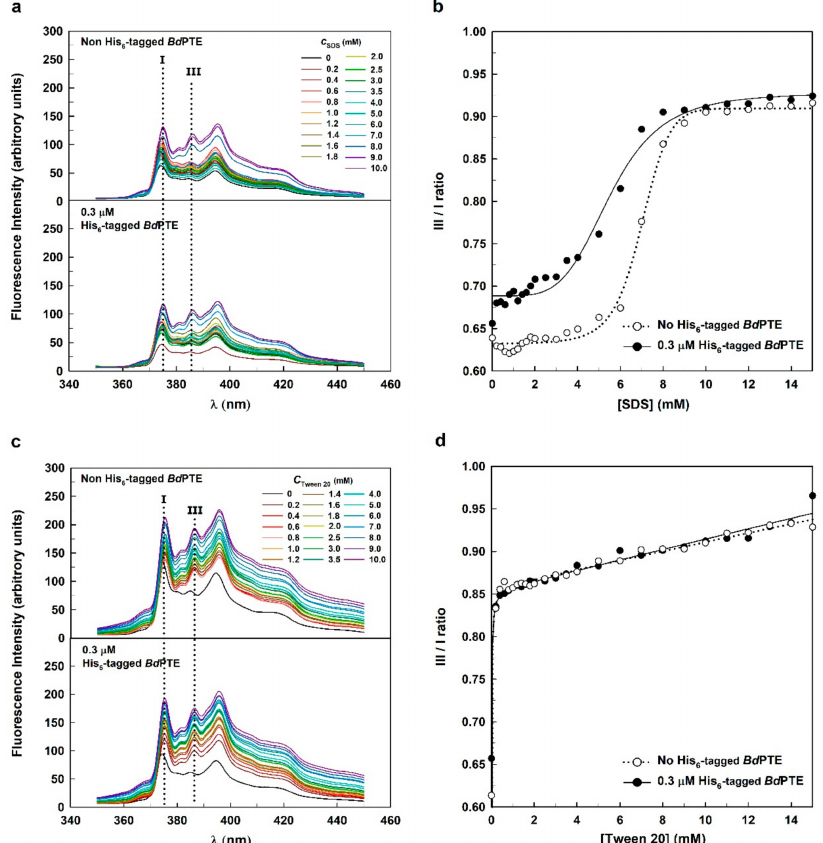
Figure 4. Fluorescence emission spectra of pyrene with a series of concentrations of SDS ( a ) and Tween 20 ( c ), and the rela- tionship between surfactant concentration and the I 3 / I 1 ratio of pyrene ( b , d